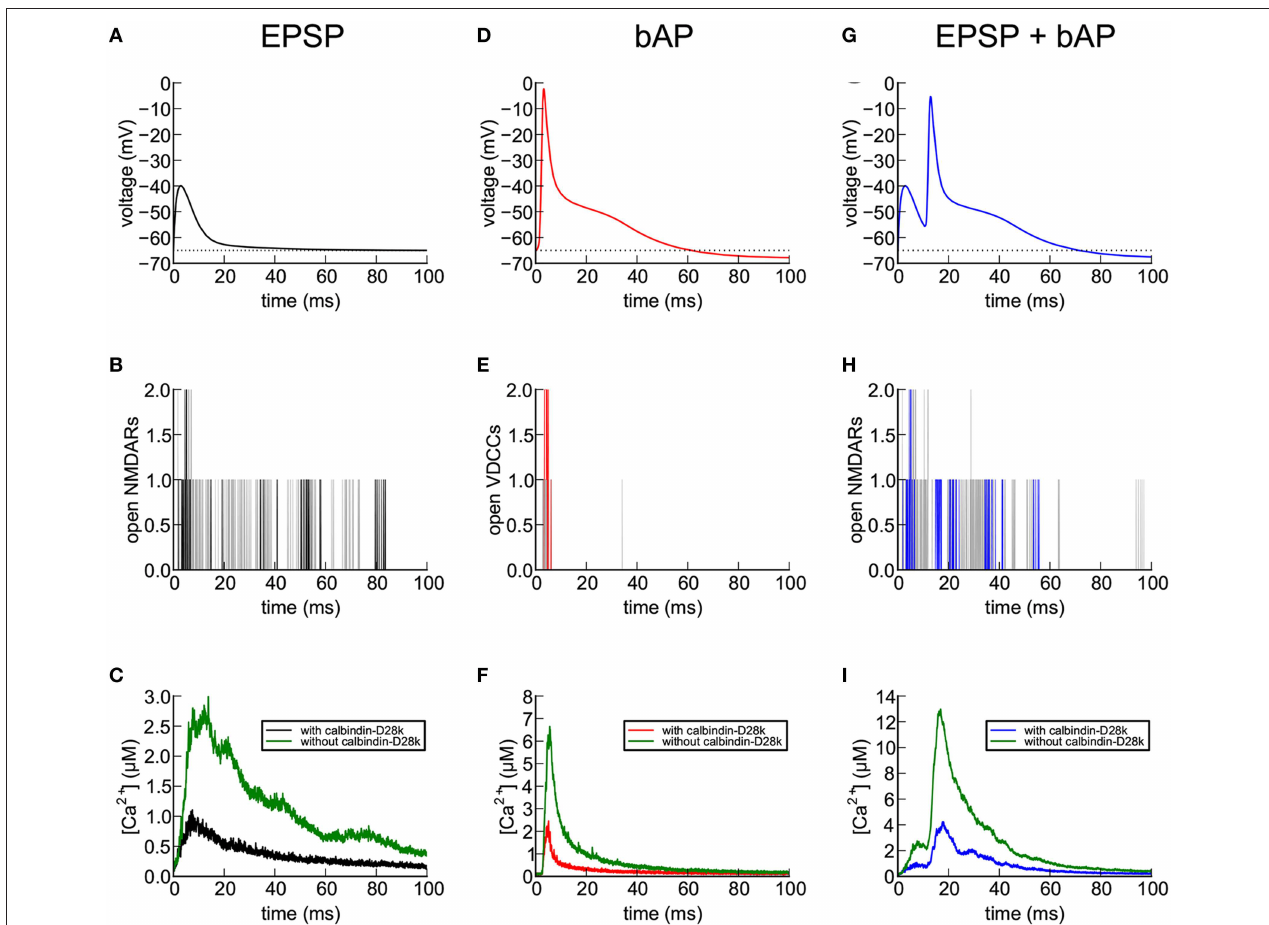
FIGURE 7 | Calcium entry into spines in response to EPSP, bAP, and EPSP+bAP stimuli. Unless otherwise stated, the dendrite contained 45 µ M calbindin-D28k and the signals are those recorded in spine #37. (A) Depolarization of the spine head following an EPSP stimulus. The voltage signal was generated from a NEURON simulation, as described in Methods Section. (B) NMDARs flickered between open and closed states during an EPSP. The black trace shows a single trial. Gray traces are superposition of five additional trials. (C) Ca 2 + transients in the spine head in response to a single EPSP stimulus averaged over 56 trials in the presence (black) and absence (green) of calbindin-D28k. (D) Depolarization of the spine head following a bAP stimulus. The voltage signal was generated from a NEURON simulation as described in Methods Section). (E) VDCCs flickered between open and closed states during the bAP. The red trace shows a single trial. Gray traces are superposition of five additional trials. (F) Ca 2 + transients in the spine head in response to a single bAP stimulus averaged over 32 trials in the presence (red) and absence (green) of calbindin-D28k. (G) Depolarization of the spine head following an EPSP+bAP stimulus. The voltage signal was generated from a NEURON simulation as described in Methods Section. (H) NMDARs flickered between open and closed states during an EPSP+bAP. The blue trace shows a single trial. Gray traces are superposition of five additional trials. (I) Ca 2 + transients in the spine head in response to a single EPSP+bAP stimulus averaged over 86 trials in